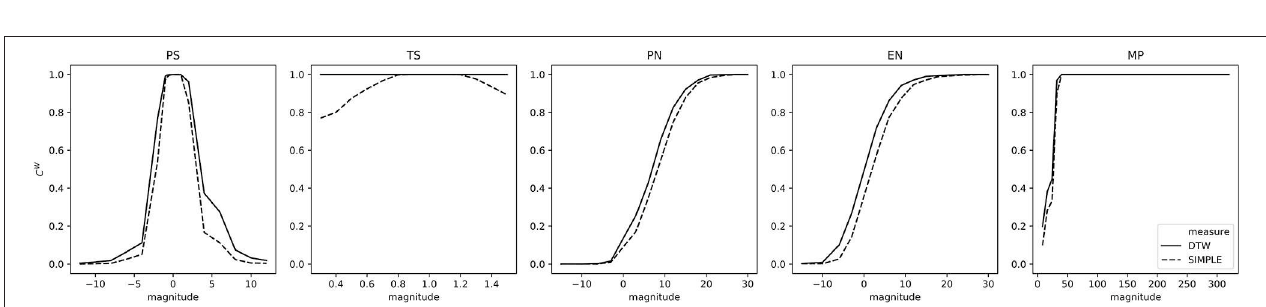
FIGURE 5 | Estimated marginal mean of standardized performance by encoders and tasks, with 95% confidence intervals. Blue points and brown points indicate the performance of MFCC and VGG-like, respectively.